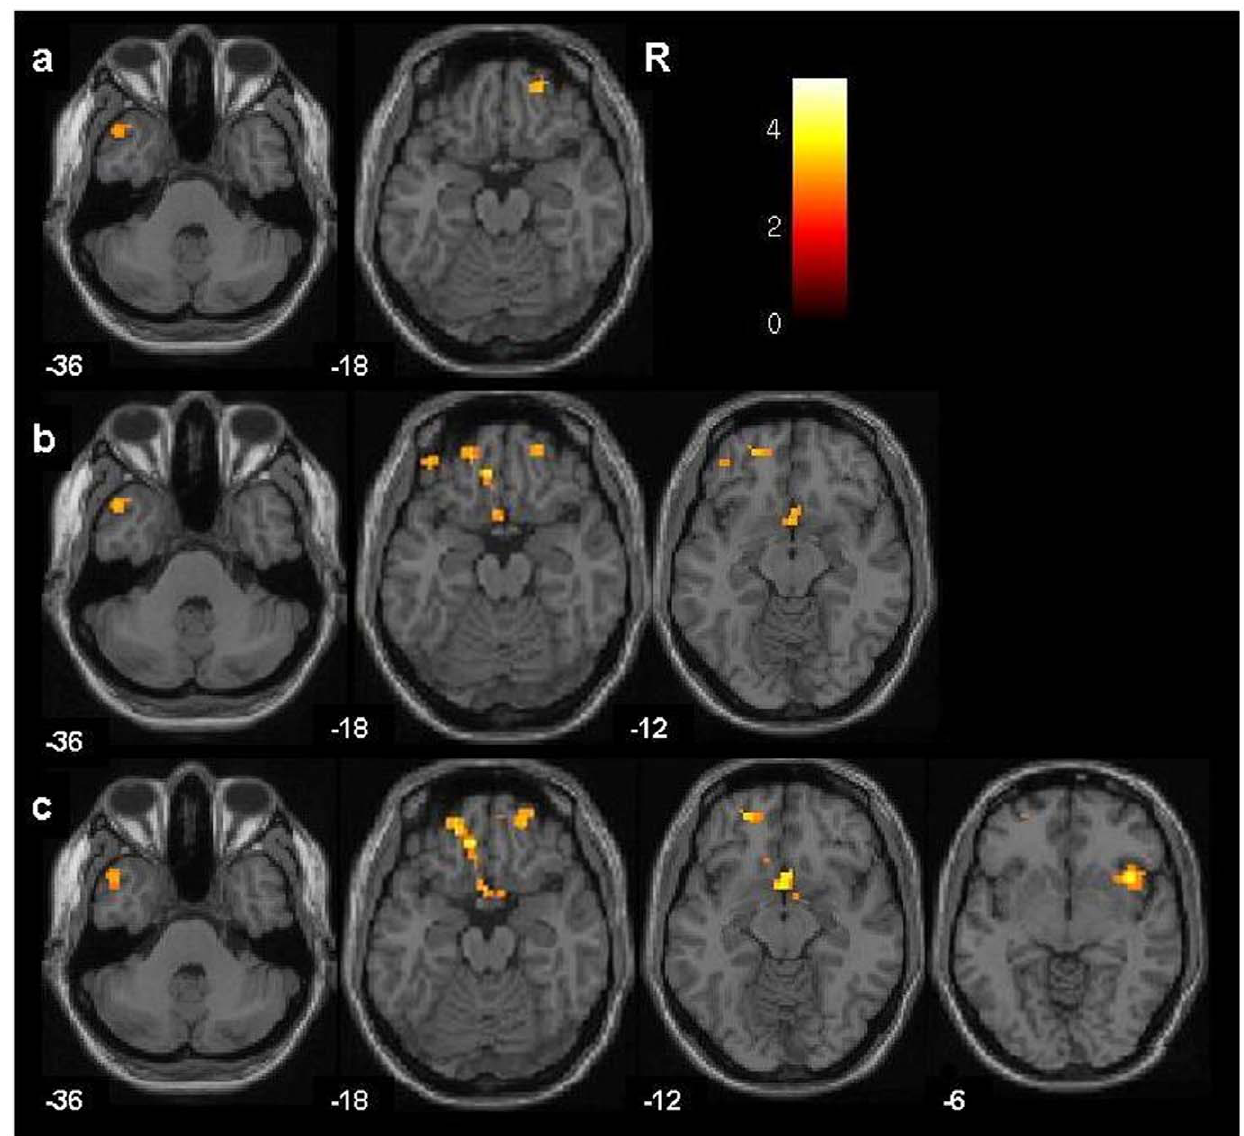
Figure 1. The axial-oblique images display regions where functional connectivity was significantly decreased (p , 0.005, cluster . 20) in 21 adolescents with bipolar disorder, compared to 36 healthy comparison participants during fearful (a), happy (b) and neutral (c) faces processing. The color bar represents the range of T values. Montreal Neurological Institute z-plane coordinates (millimeters) are presented.